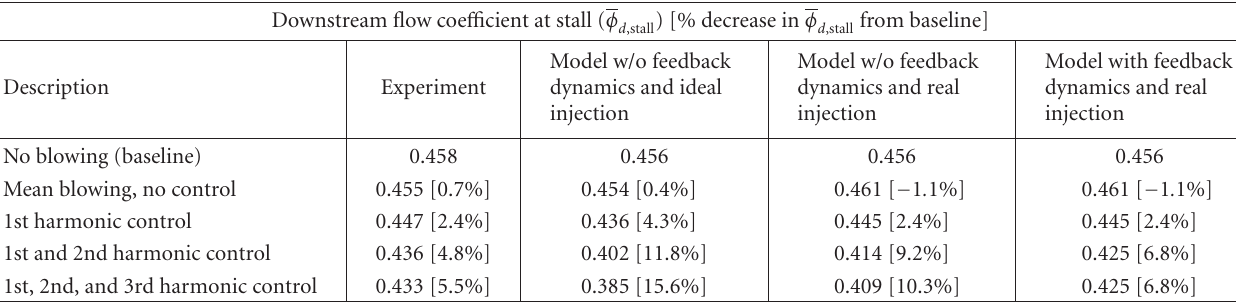
Table 1: Summary of experimental and theoretical stall flow coe ffi cients with optimized closed-loop control.